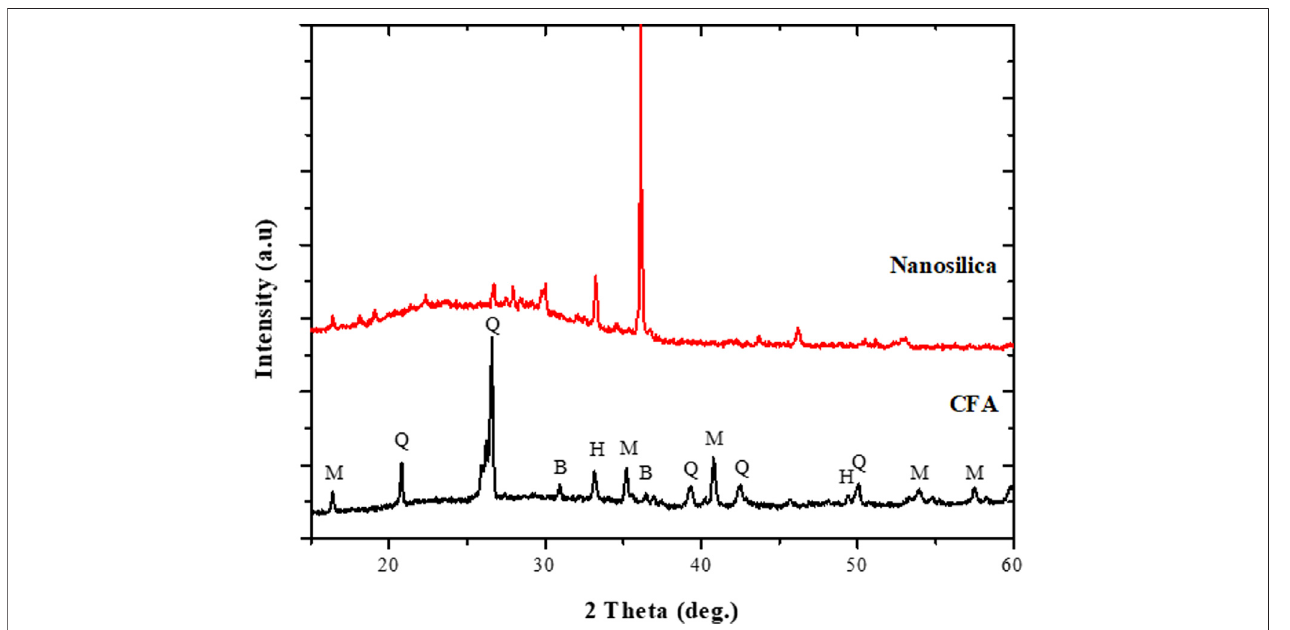
FIGURE 1 | XRD patterns of raw CFA and extracted